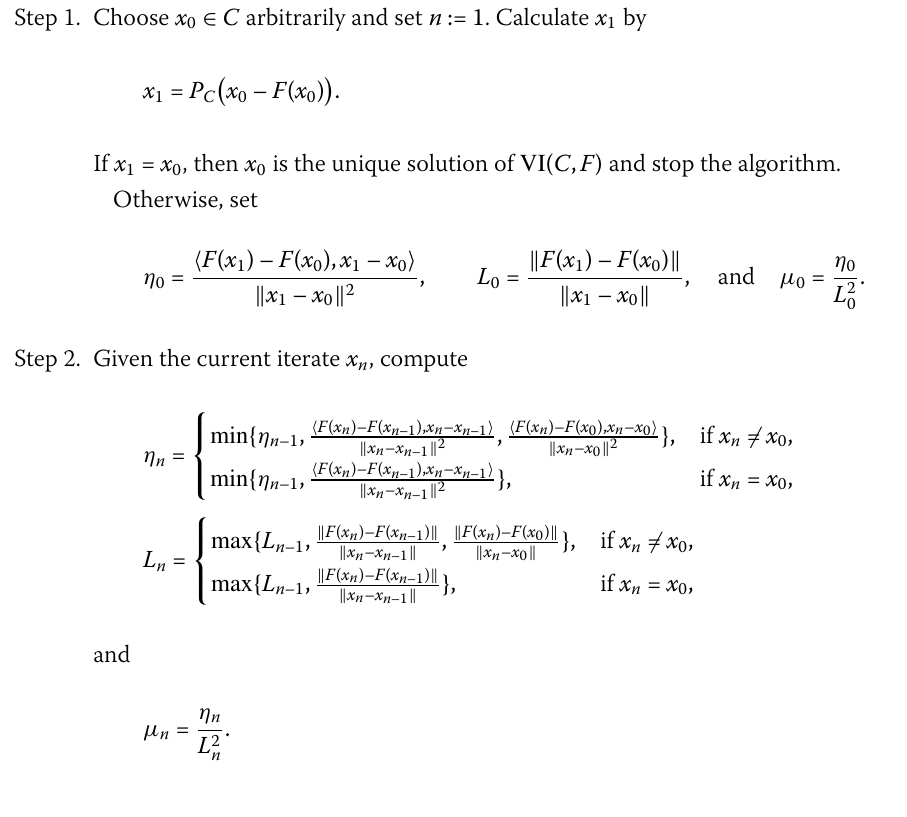
Algorithm 3.1 (Self-adaptive iterative